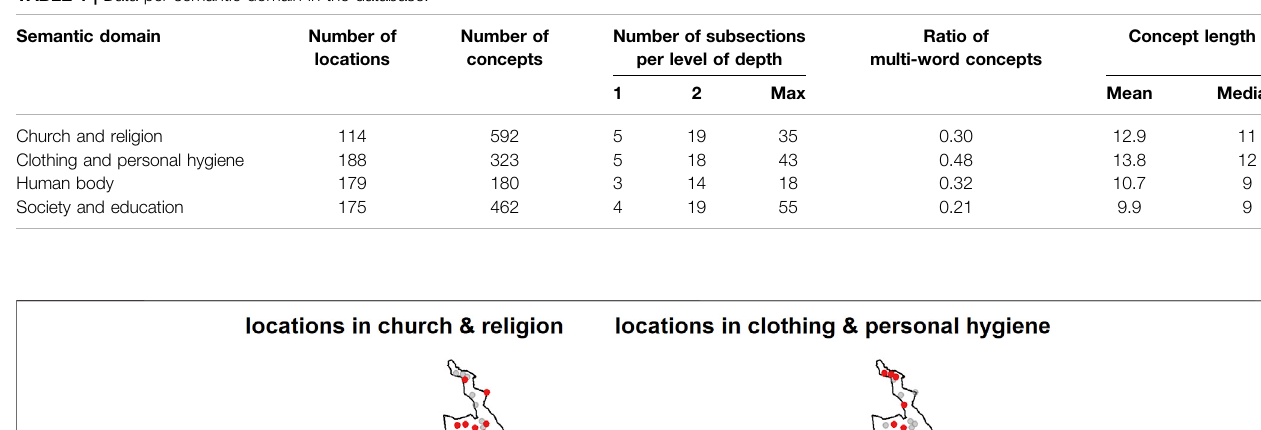
TABLE 1 | Data per semantic domain in the database.